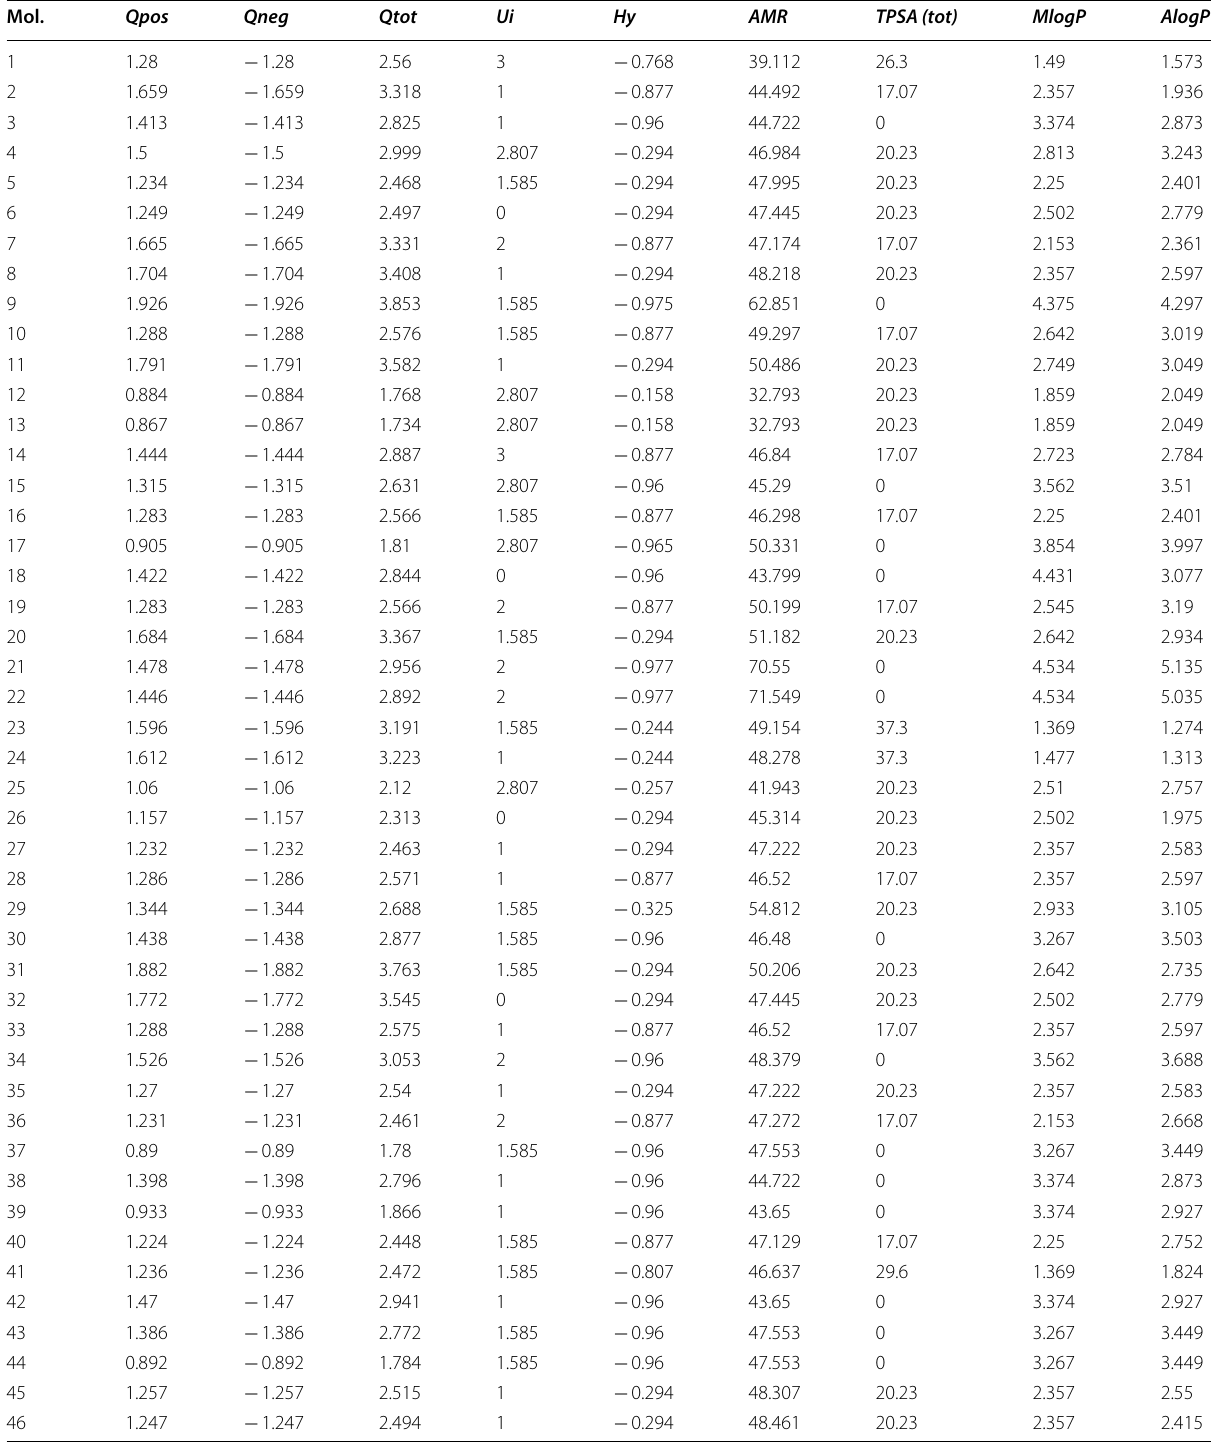
Table 5 Molecular and physicochemical descriptors calculated